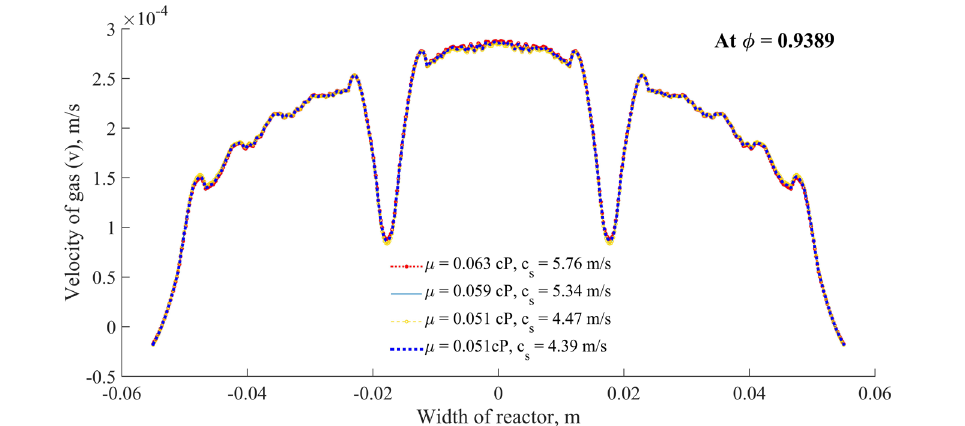
Fig. 8. Variation of velocity of volatile gas ( v ) with respect to dynamic viscosity (μ) and lattice speed of sound ( c s ) at constant voidage